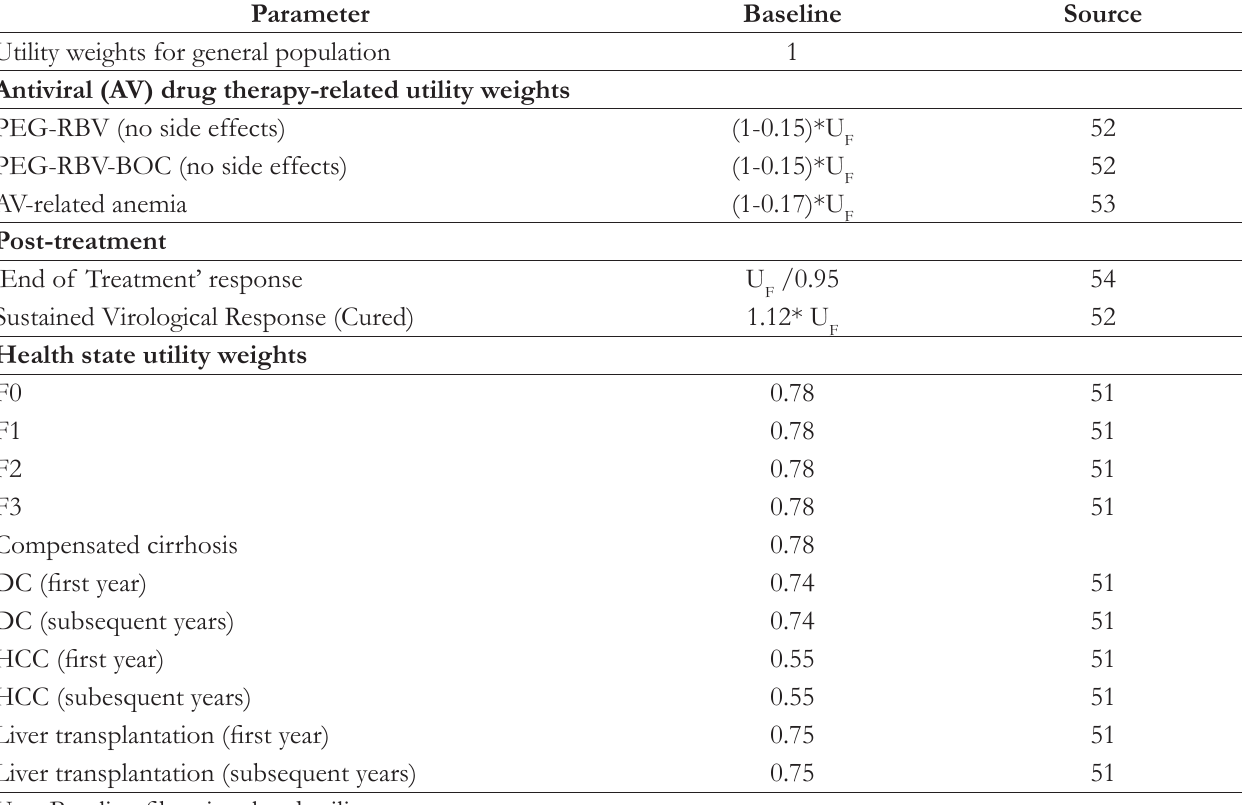
Table 5. Parameters of Utility Parameter